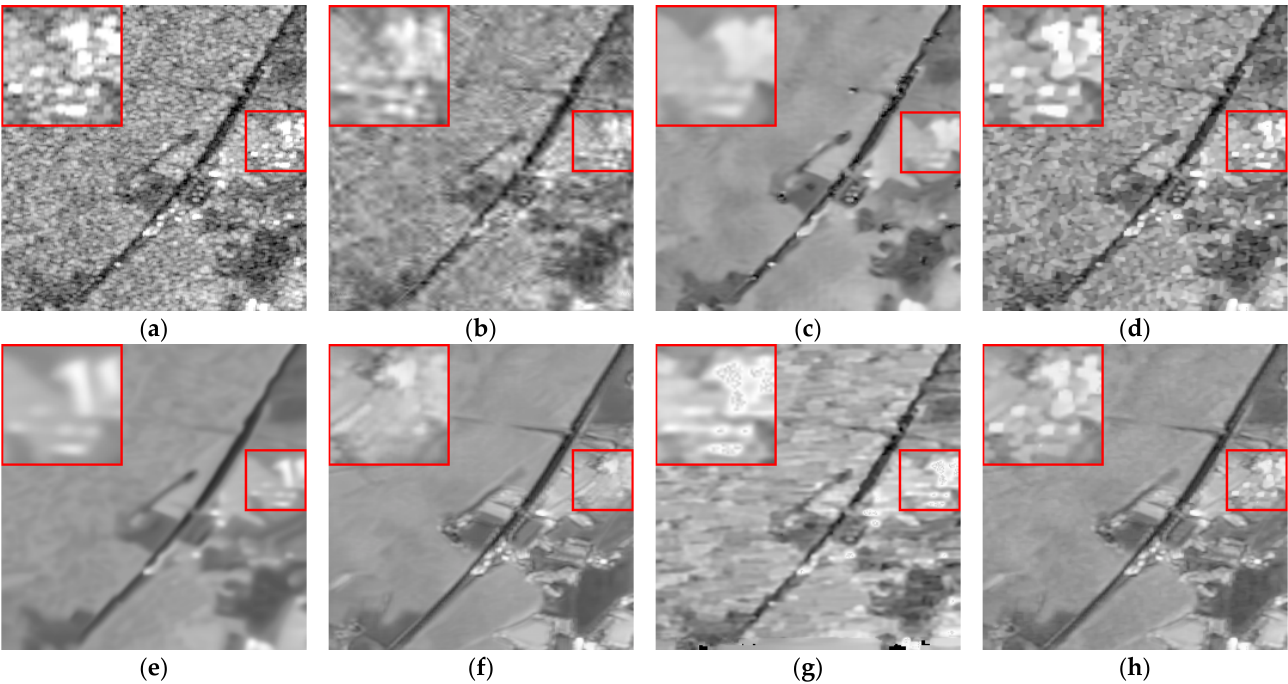
Figure 15. The results of all filters on RS2. The red box highlights the zoomed region of interest. ( a ) Noisy image; ( b ) W-C; ( c ) PPB; ( d ) SAR-BM3D; ( e ) H-WNNM; ( f ) GNLM; ( g ) FANS; ( h ) Proposed method.